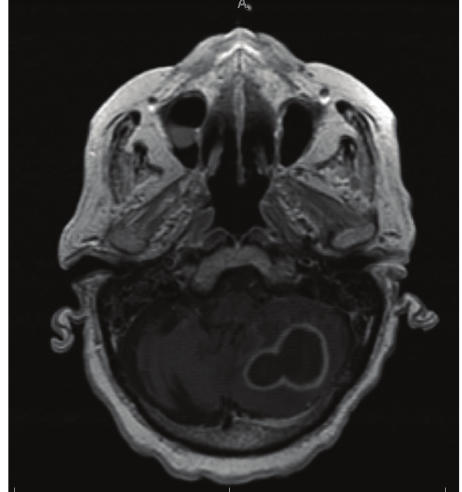
Figure 6: Magnetic resonance imaging of the brain showing ring enhancinglesionintheleftcerebellumwithmasseffectonthefourth ventricle, one month after initial presentation.